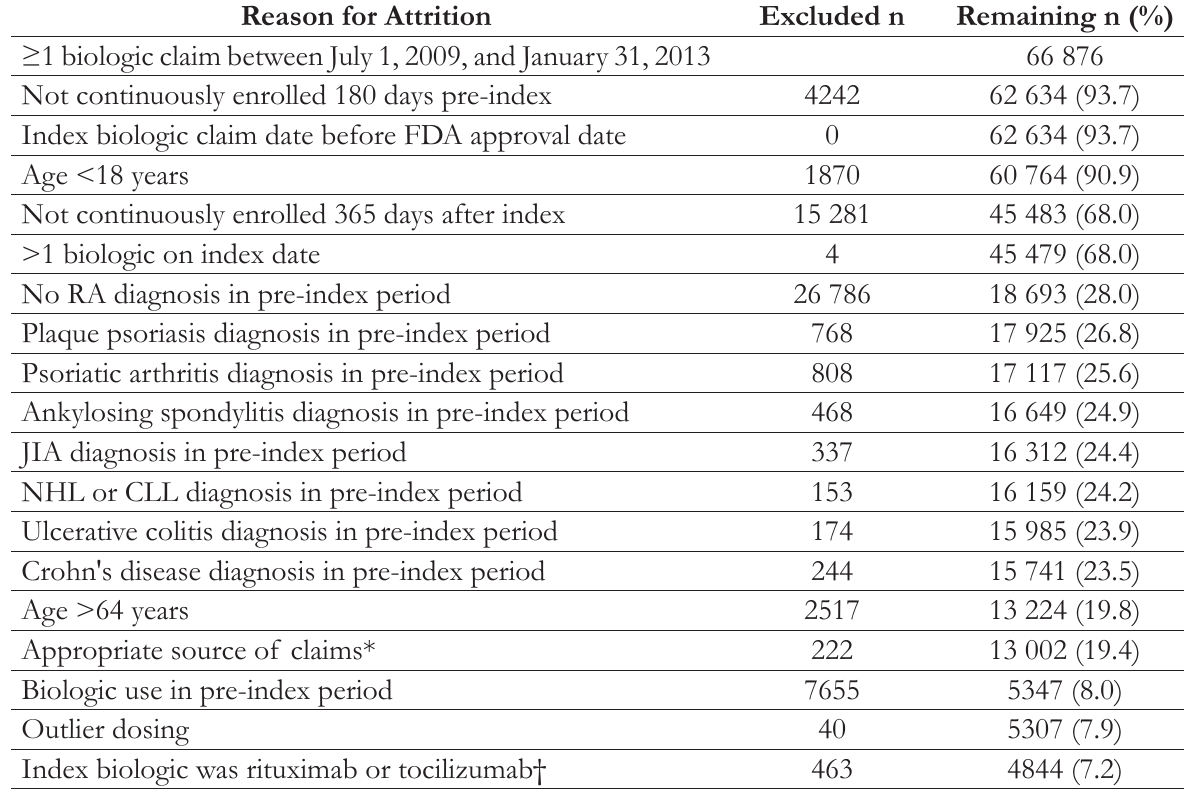
Table 1. Selection of Study